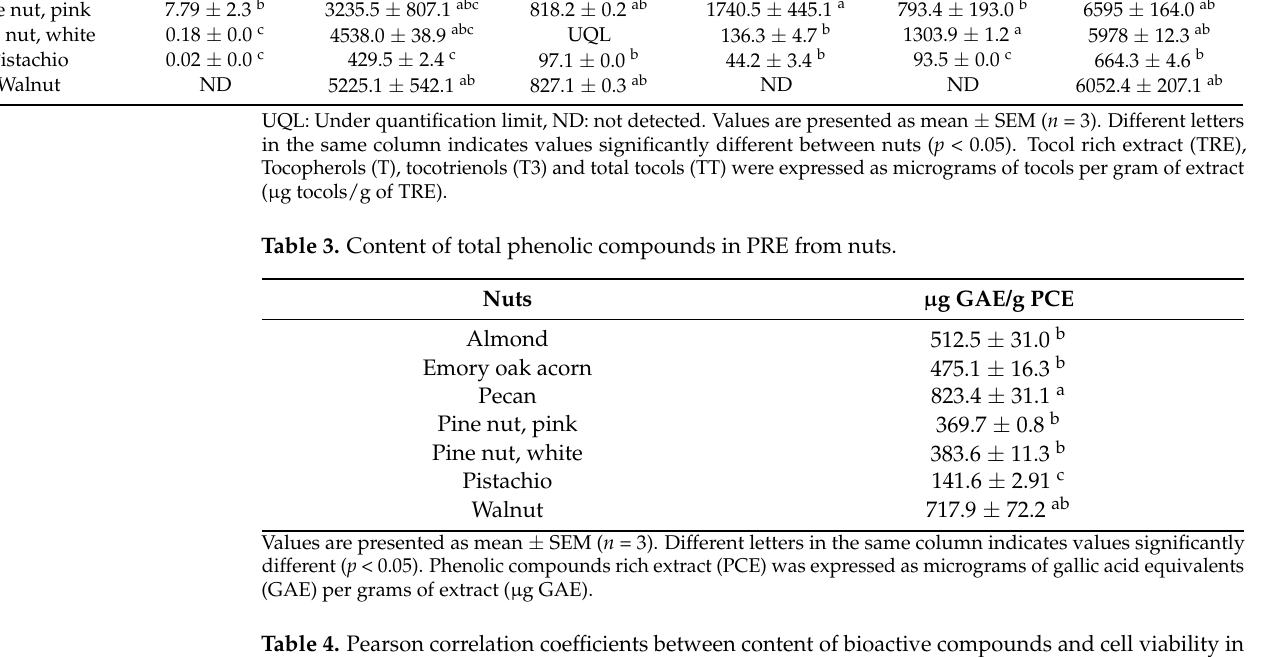
Table 4. Pearson correlation coefficients between content of bioactive compounds and cell viability in TRE- and PRE-treated cell